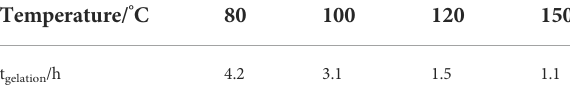
TABLE 4 Impact of temperature in clear water on gelling time.